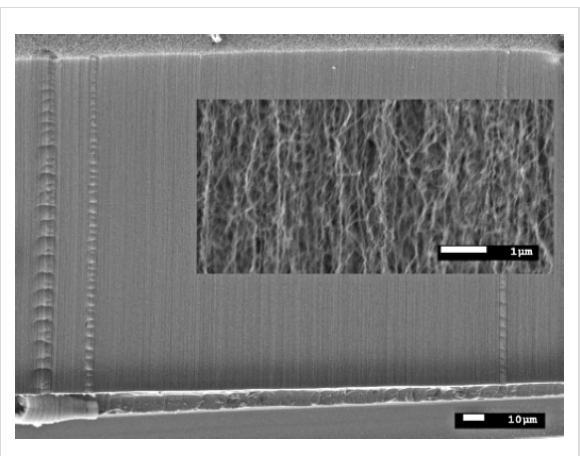
Figure 1: Example of scanning electron microscopy image of carbon nanotubes aligned perpendicularly to the substrates and synthesized on 30 Å Fe/300 Å Al 2 O 3 /SiO 2 /Si for 30 min (C 2 H 4 /H 2 35/130 sccm) at 750 °C.